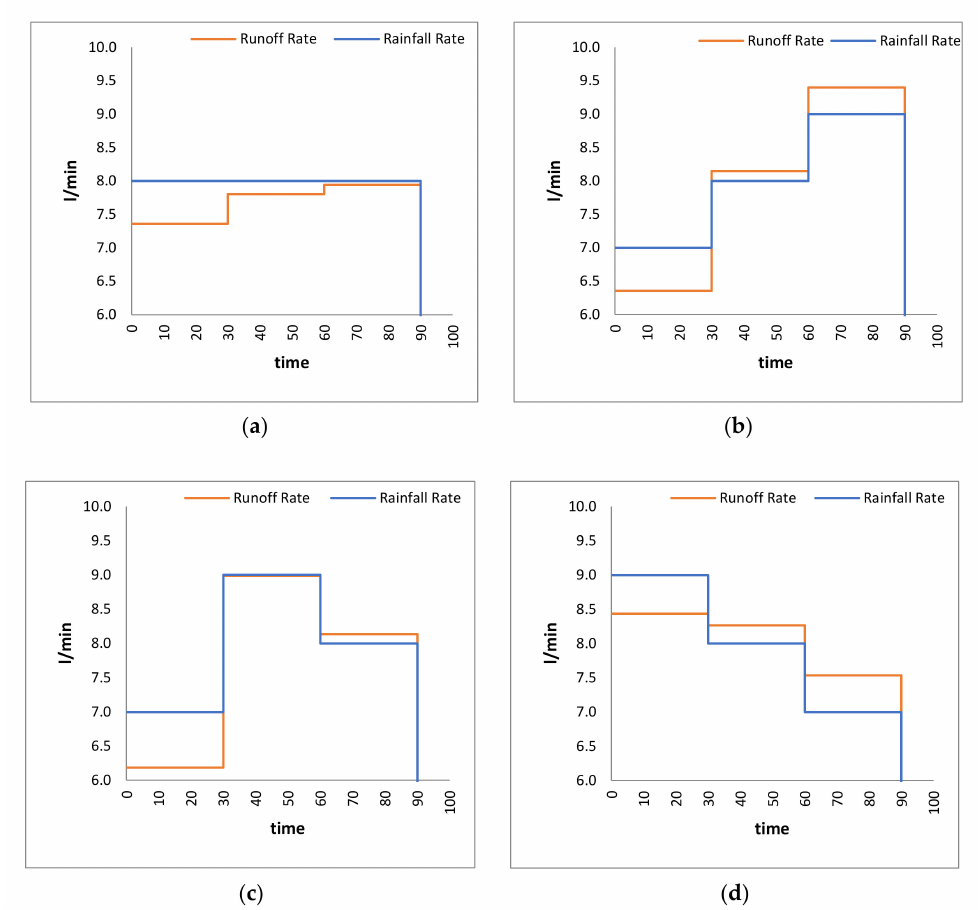
Figure 4. Comparison of rainfall and runoff rate for each rainfall pattern: ( a ) CST; ( b ) ICR; ( c ) ICRDCR; ( d )